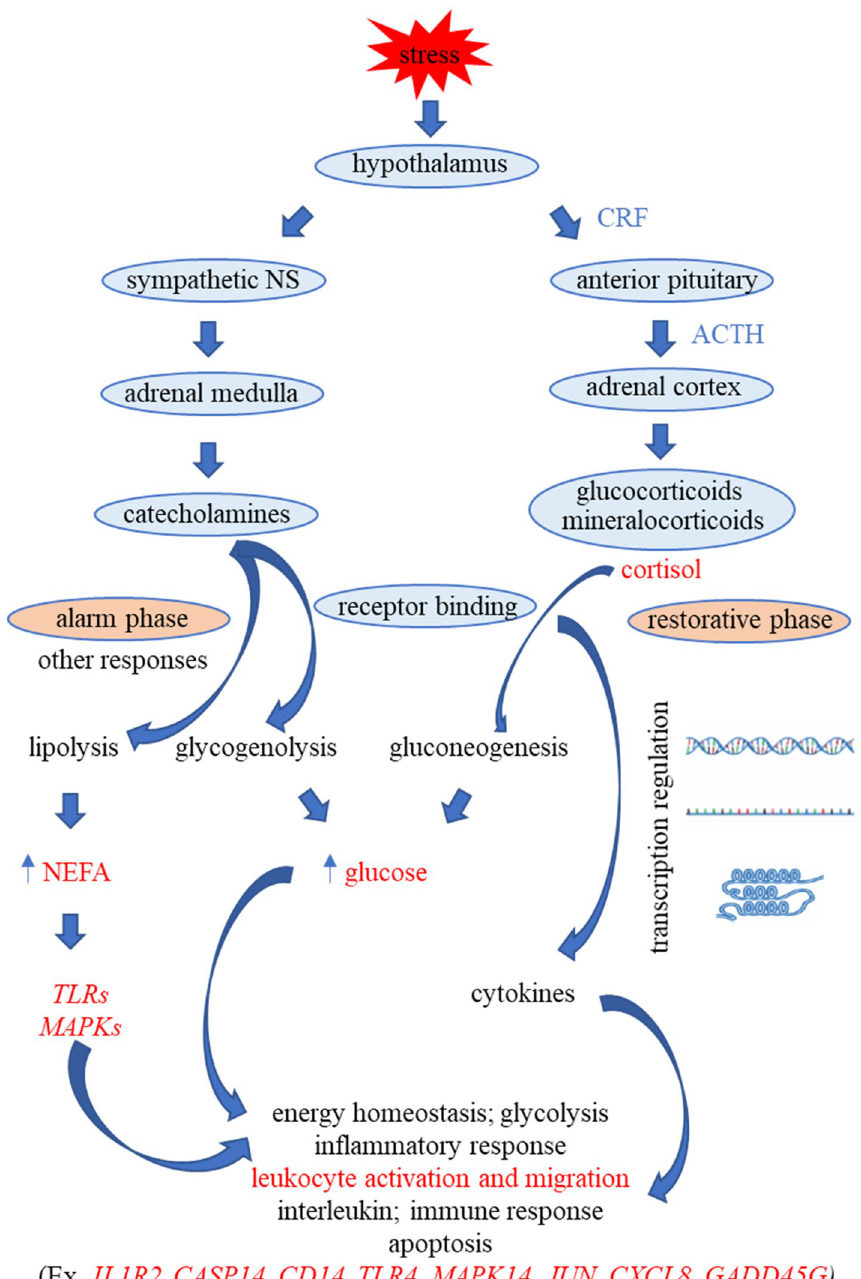
Figure 9. A mechanism model showing the possible relationships among the physiological stress responses measured and differentially expressed genes identified in the blood of goats in this